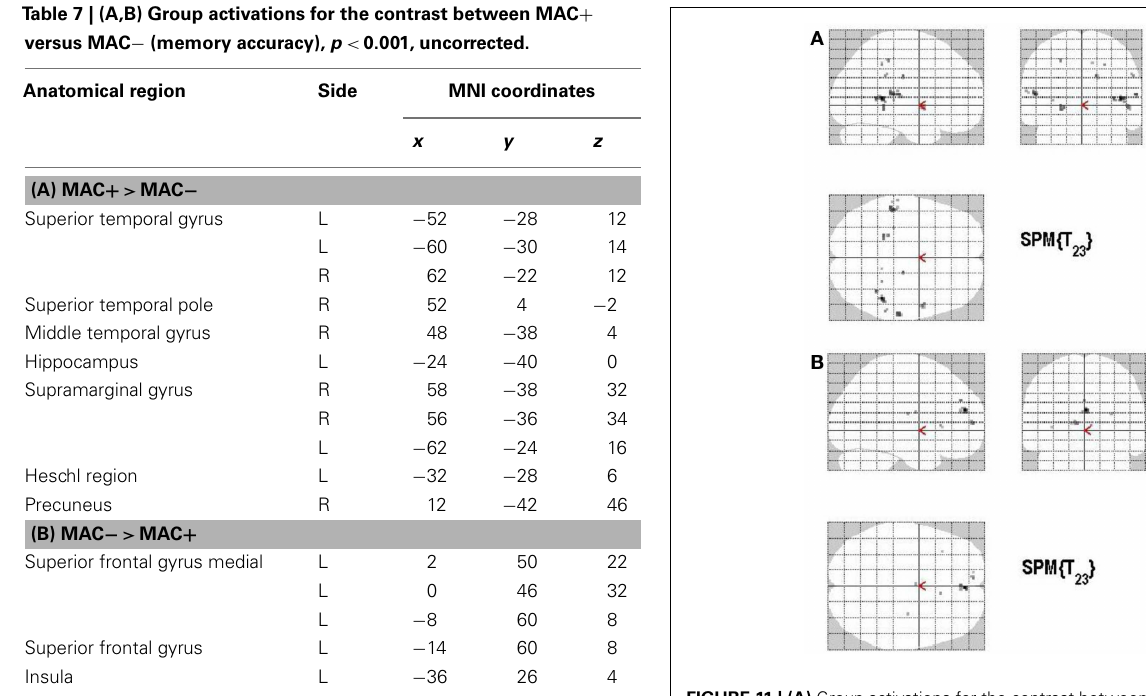
FIGURE 11 | (A) Group activations for the contrast between ACC + versus ACC − (ACCURACY). Activations are superimposed on the anatomical group mean image (see Materials and Methods), depicting statistically significant relative increases in neural activity at p < 0.001, uncorrected. See Table 7A for the exact MNI coordinates. (B) Group activations for the contrast between ACC − versus ACC + (ACCURACY). Activations are superimposed on the anatomical group mean image (see Materials and Methods), depicting statistically significant relative increases in neural activity at p < 0.001, uncorrected. See Table 7B for the exact MNI